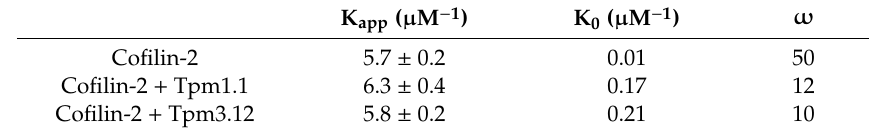
Figure 2. Binding of cofilin-2 to F-actin alone and to F-actin initially saturated with tropomyosin. The experimental points fit to the Hill model ( A ) and the McGhee and von Hippel linear lattice model ( B ). Binding of cofilin-2 to F-actin alone (open circles, solid line), F-actin covered by Tpm1.1 (open triangles, dashed-dot-dot line) or by Tpm3.12 (open squares, dash-dot line). Protein concentration: 3 µ M F-actin, 1 µ M Tpm1.1 or Tpm3.12, 0–10 µ M cofilin-2. Bu ff er: 100 mM NaCl, 2.0 mM MgCl 2 , 1 mM DTT, 5.0 mM Tris–HCl, pH 7.5. The points are from three experiments. Inset in panel ( A ) illustrates saturation of F-actin alone as a function of total concentration of cofilin-2. Table 2. Parameters of cofilin-2 binding to F-actin in the presence and absence of tropomyosin